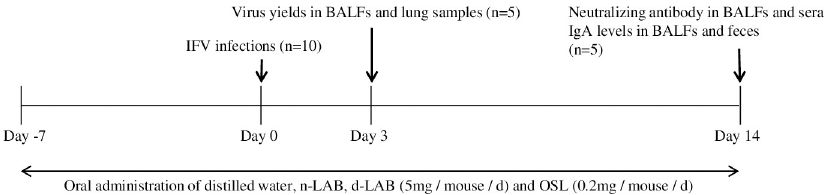
Fig 1. Experimental procedure of influenza virus infection. Mice in the control, n-LAB, d-LAB, and OSL groups were administered distilled water, n-LAB (5 mg/day), d-LAB (5 mg/day, two doses daily) and OSL (0.2 mg/day, two doses daily), respectively, during the study period (days − 7 to 14). Mice were intranasally infected with IFV on day 0. On day 3 after IFV infection, 5 mice from each group were euthanized to quantify virus load in the lungs and BALF. Further, 5 mice were euthanized for measuring neutralizing antibody and IgA levels on day 14. BALF, bronchoalveolar lavage fluid; d-LAB, dispersed lactic acid bacteria; IFV, influenza A virus; n-LAB, non-treated lactic acid bacteria; OSL, oseltamivir